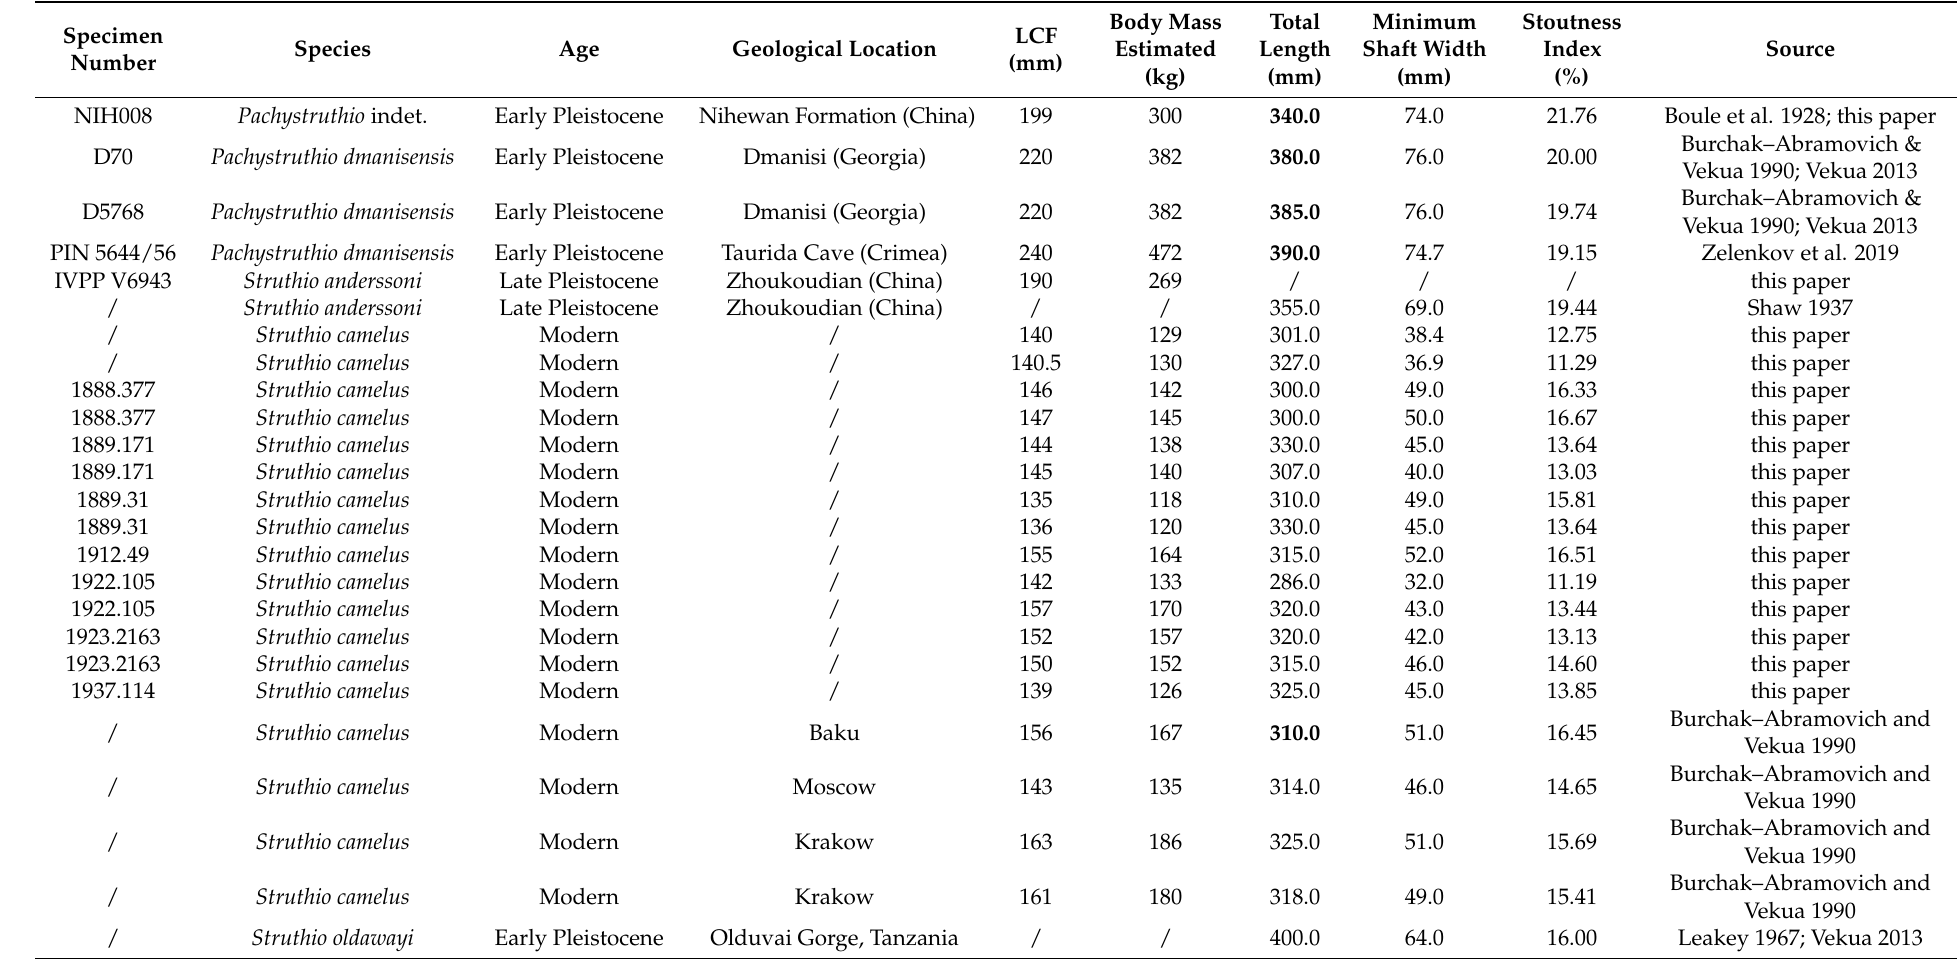
Table 1. Summary table of the measurements of the fossil Struthionidae from the Pleistocene of Eurasia and Africa compared with the modern Struthio camelus . Bold total length values are estimated. LCF: minimum circumference of the shaft of the